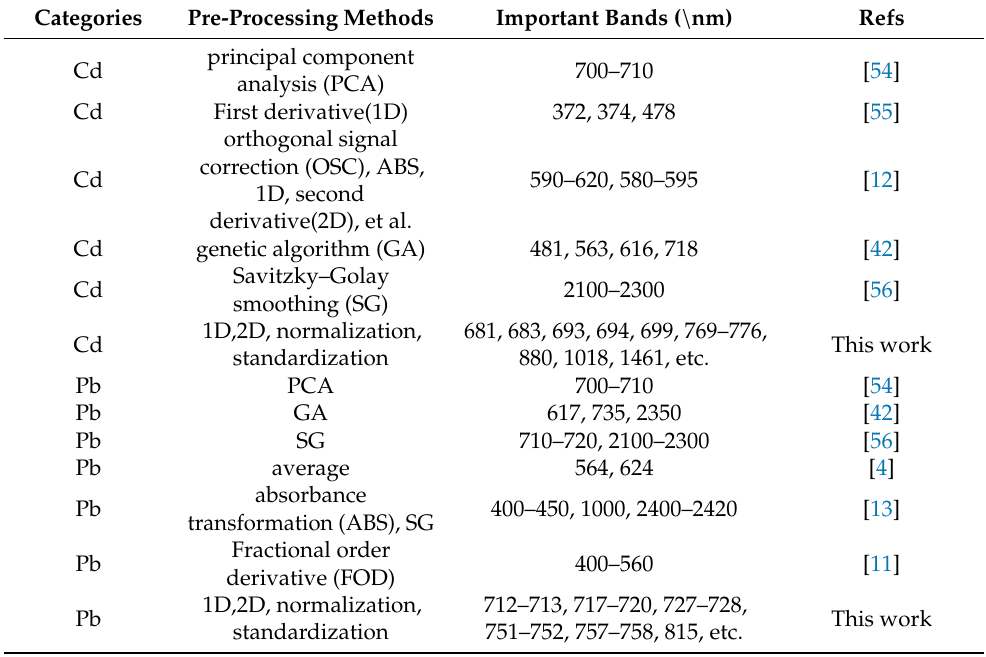
Table 5. Methods of hyperspectral data pre-processing for estimating Cd–Pb